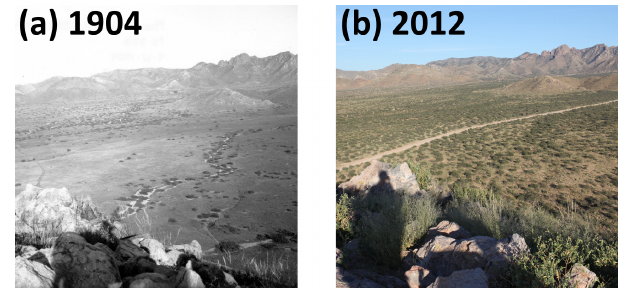
Figure 2. Scattered shrubs replace grasses as dominant vegetation between 1904 (a) and 2012 (b) in the Santa Rita Experimental Range, AZ, US. Facing north-northeast in pastures 6B and 6D. El- evation is 1228ma.s.l. (public domain images available from https: //cals.arizona.edu/srer/photos.html, last access: 27 April